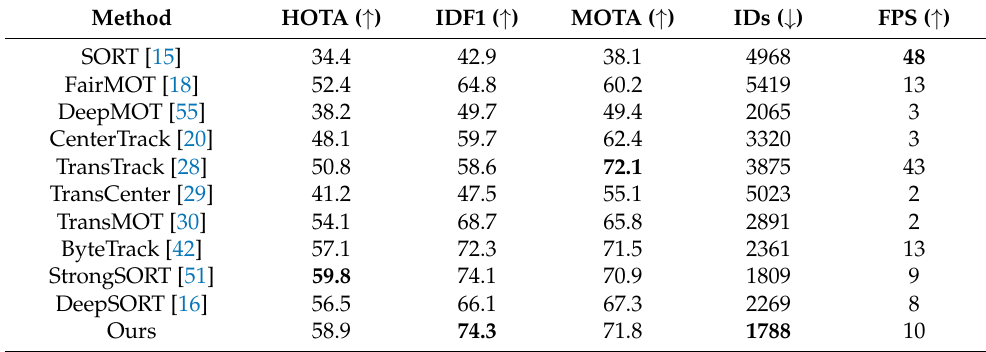
Table 3. Comparison with state-of-the-art MOT methods on the MOT20 test set (YOLOv7). Method